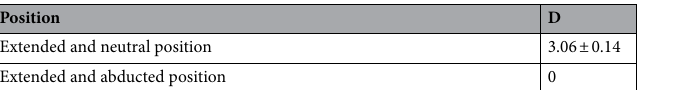
Table 3. The distance between A and B in different positions of thumb ( x ± s, mm) .